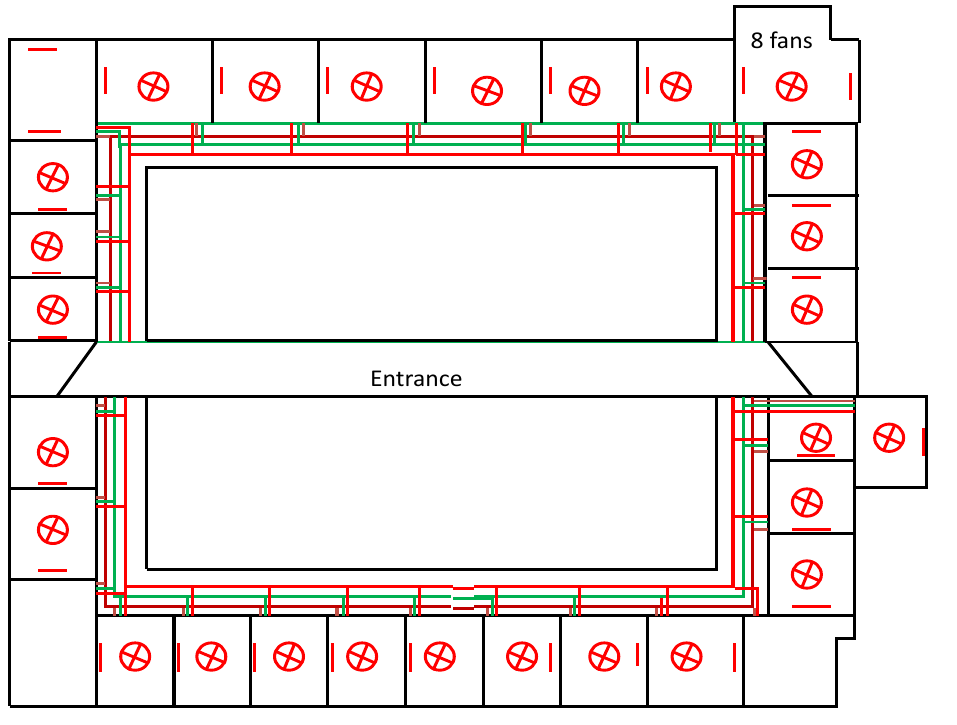
Figure 3. Sketch of the Rahman Baba Hostel. Table 3. Rahman Baba Hostel existing load data. Room